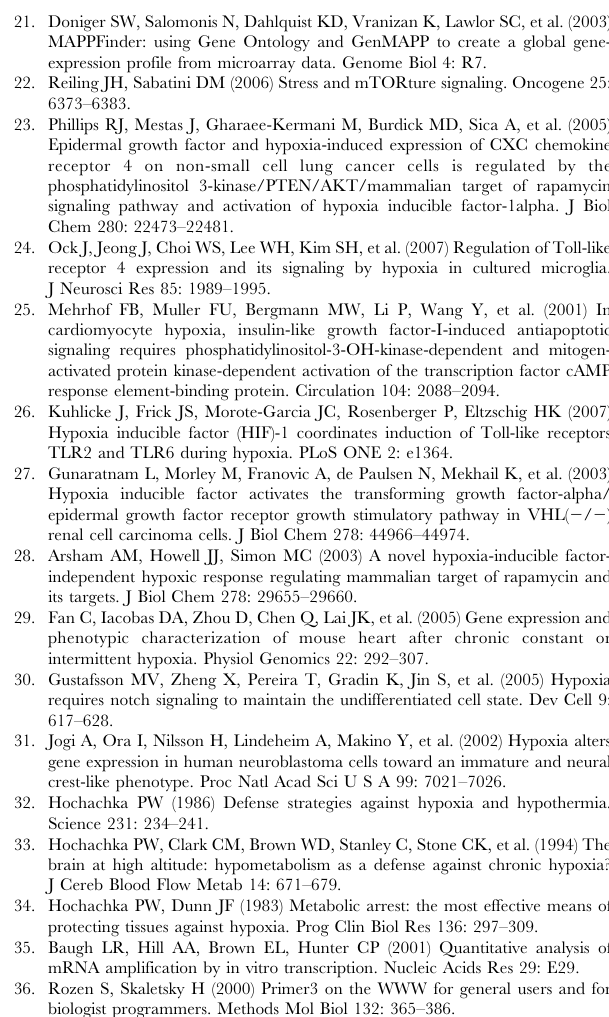
Figure S1 Correlation between Microarray and qRT-PCR Results. Table S1 List of Significantly Altered Genes in Hypoxia- Selected Drosophila melanogaster at Larval Stage. Table S2 List of Significantly Altered Genes in Hypoxia- Selected Drosophila melanogaster at Adult Stage. Table S3 List of Significantly Altered Biological Processes in Hypoxia-Selected Drosophila melanogaster at Larval Stage. Table S4 List of Significantly Altered Biological Processes in Hypoxia-Selected Drosophila melanogaster at Adult Stage.